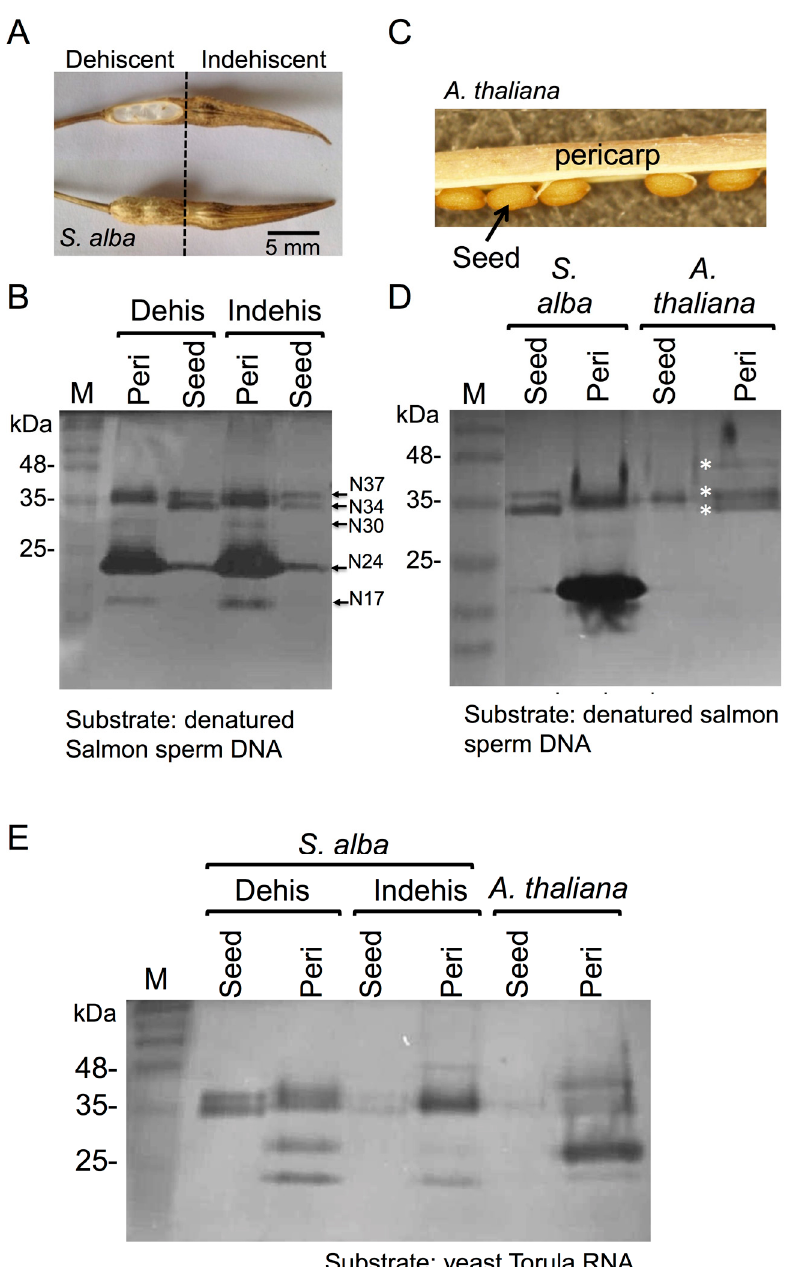
Figure 1. The dead pericarps of S. alba and A. thaliana releases active nucleases and RNAses. Ground pericarps derived from S. alba and A. thaliana were extracted with PBS buffer at 4 °C for 12 h and substances released were examined for nuclease activity. ( A ) Fruit of the S. alba dehiscent and indehiscent parts. ( B ) In gel nuclease assay demonstrating nuclease activity in dead dehiscent and indehiscent pericarps of S. alba . ( C ) Dehiscent fruit of Arabidopsis thaliana . Seeds and pericarp are indicated. ( D ) In gel nuclease assay demonstrating nuclease activity in pericarps of A. thaliana . Active nucleases are marked by white asterisks. ( E ) In gel RNase assay of proteins released from pericarps of S. alba and A. thaliana . M, protein molecular weight markers (in kDa).